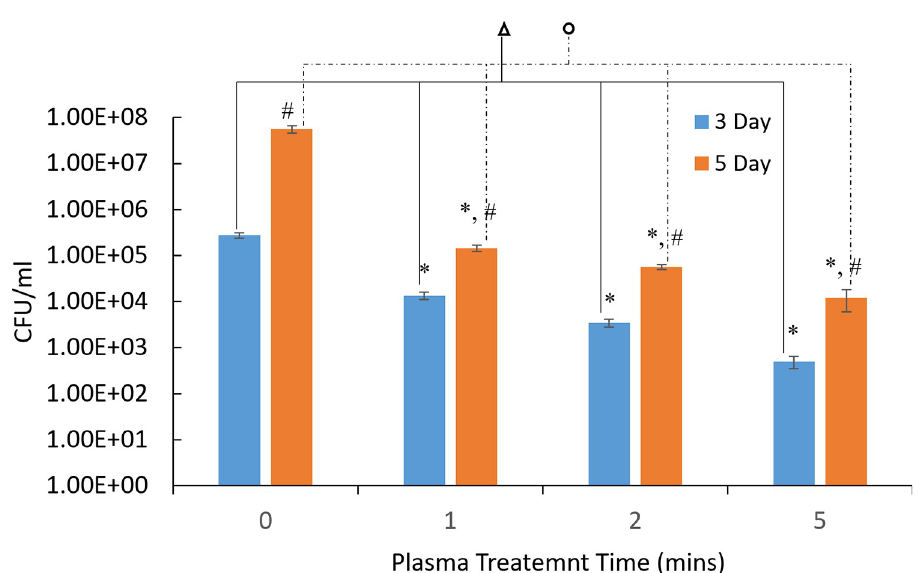
Fig 5. CFU counting assay results of argon+1% oxygen plasma destruction of 3-day and 5-day P . gingivalis biofilms. � denotes the statistically significant difference compared with the untreated control groups with p < 0.05. # denotes the statistically significant difference between 3-day and 5-day biofilms with p < 0.05 according to ANOVA Tukey test. denotes the statistically significant differences among different treatment times of 3-day biofilms with p < 0.05 according to ANOVA Tukey test. denotes the statistically significant differences among different treatment times of 5-day biofilms with p < 0.05 according to ANOVA Tukey test.